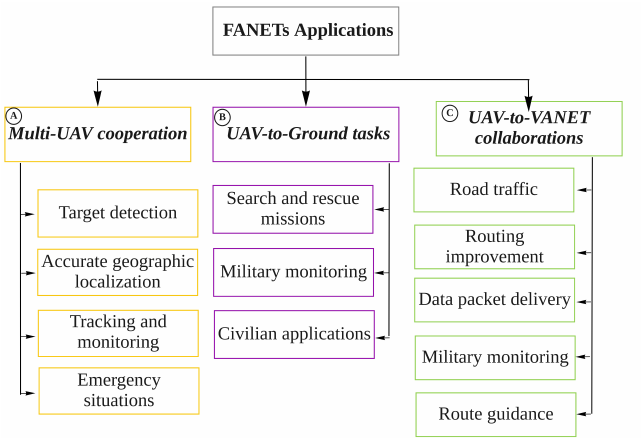
Figure 4. FANET applications: Multi-UAV cooperation, UAV-to-Ground cooperation, and UAV-to- VANET